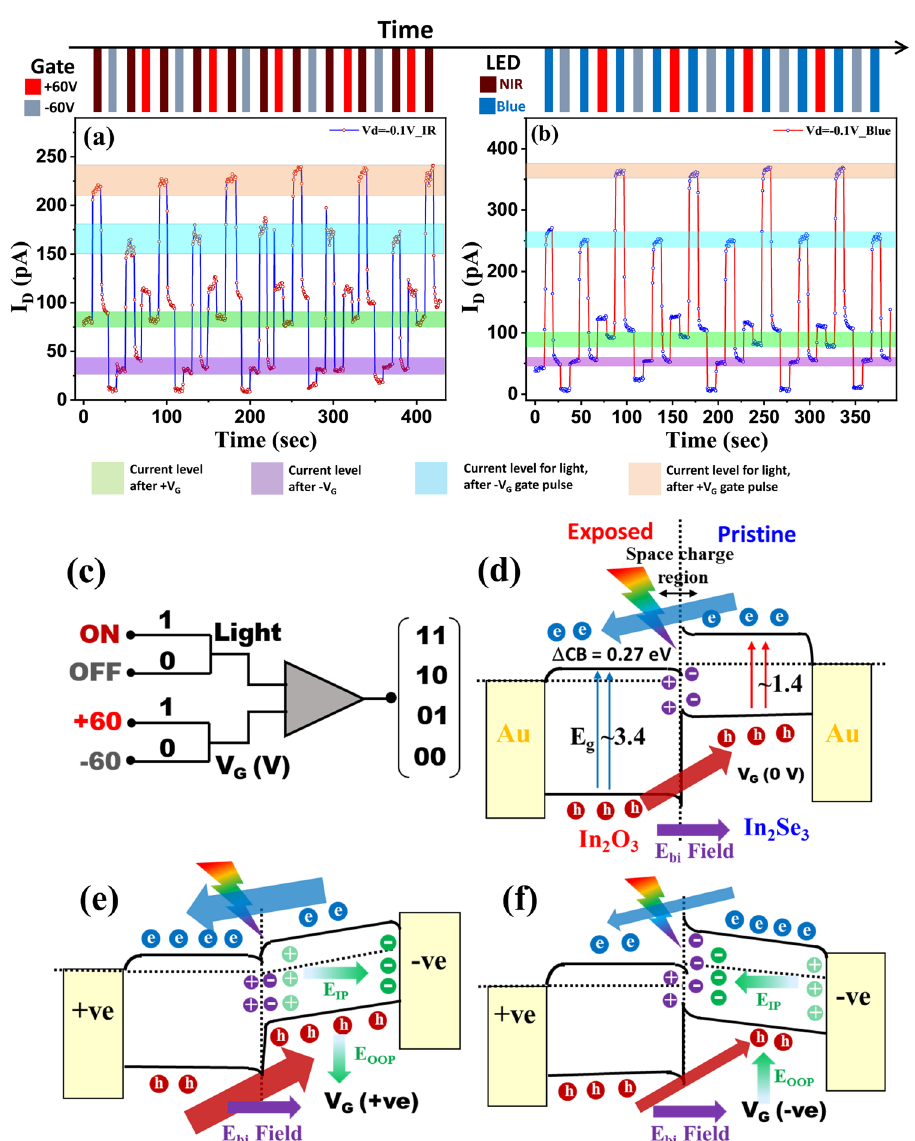
Fig. 4 Multilevel logic operation and memory characteristics upon optoelectronic inputs. Measured photoresponse during periodic illumination using ( a ) deep-Red and ( b ) Blue light and following alternating gate pulses. The photoresponse displays four distinct current levels marked by the four different color bands. c Schematic illustration of the logic circuit operation of the fabricated multibit memory device, where the gate and light pulses are supplied as input to achieve four distinct readout current levels. Schematic energy-band diagram illustration of photocarriers fl ow for different gate-bias voltages at ( d ) equilibrium (0 V G ), ( e ) + V G , and ( f ) – V G . The photocarriers fl ow and ferroelectric fi eld in In 2 Se 3 , along with the built-in fi eld directions, are marked by the blue-red, green and purple arrows, respectively. The band-bending and relative barrier heights are adapted from the surface potential pro fi les for two extreme